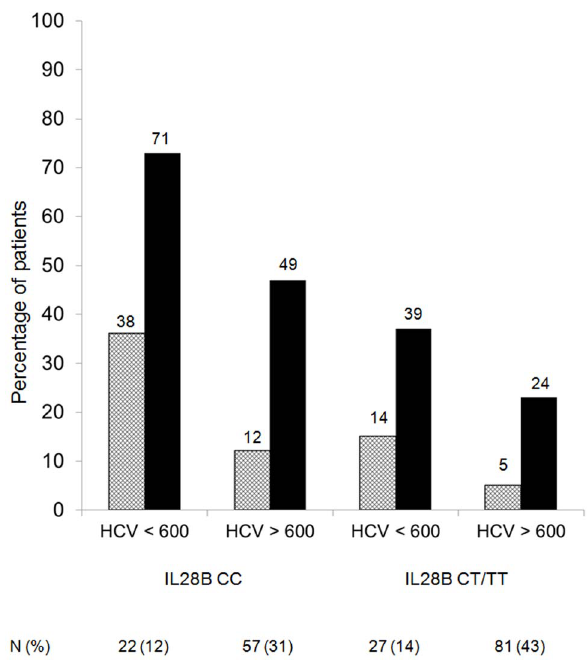
Figure 2. Percentages of HIV/HCV coinfected patients (HCV genotype 1) with rapid (lined) and sustained (black) virological response to pegylated interferon- a 2a plus ribavirin as a function of IL28B polymorphism and HCV-RNA levels.